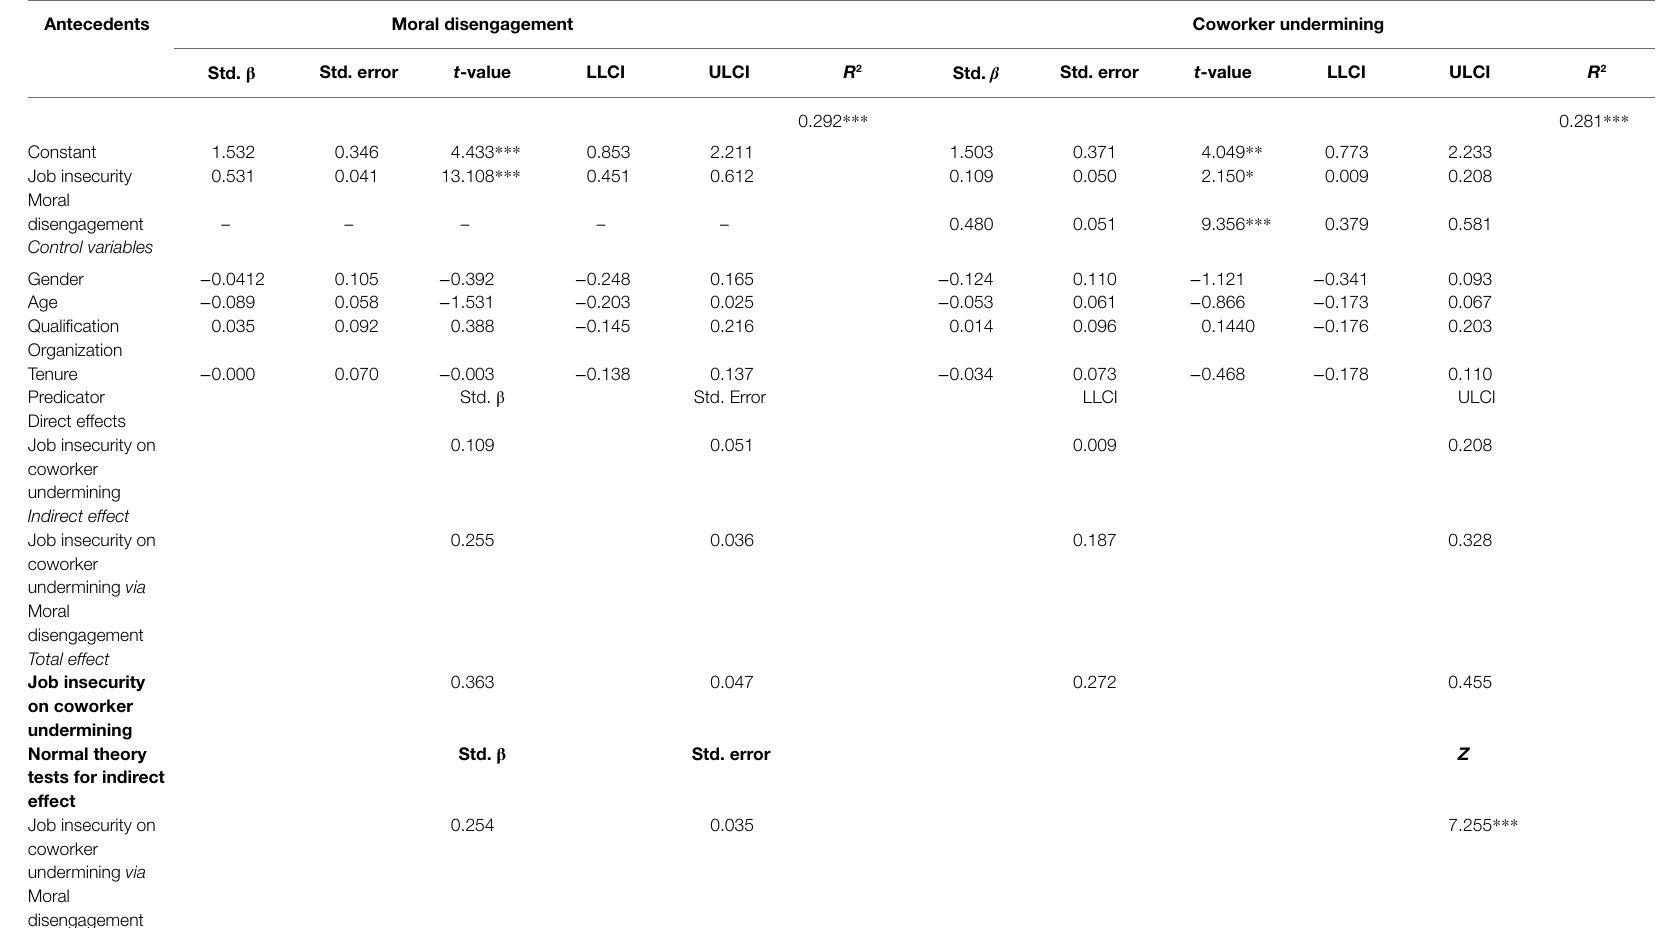
TABLE 2 | Results of mediation analysis.